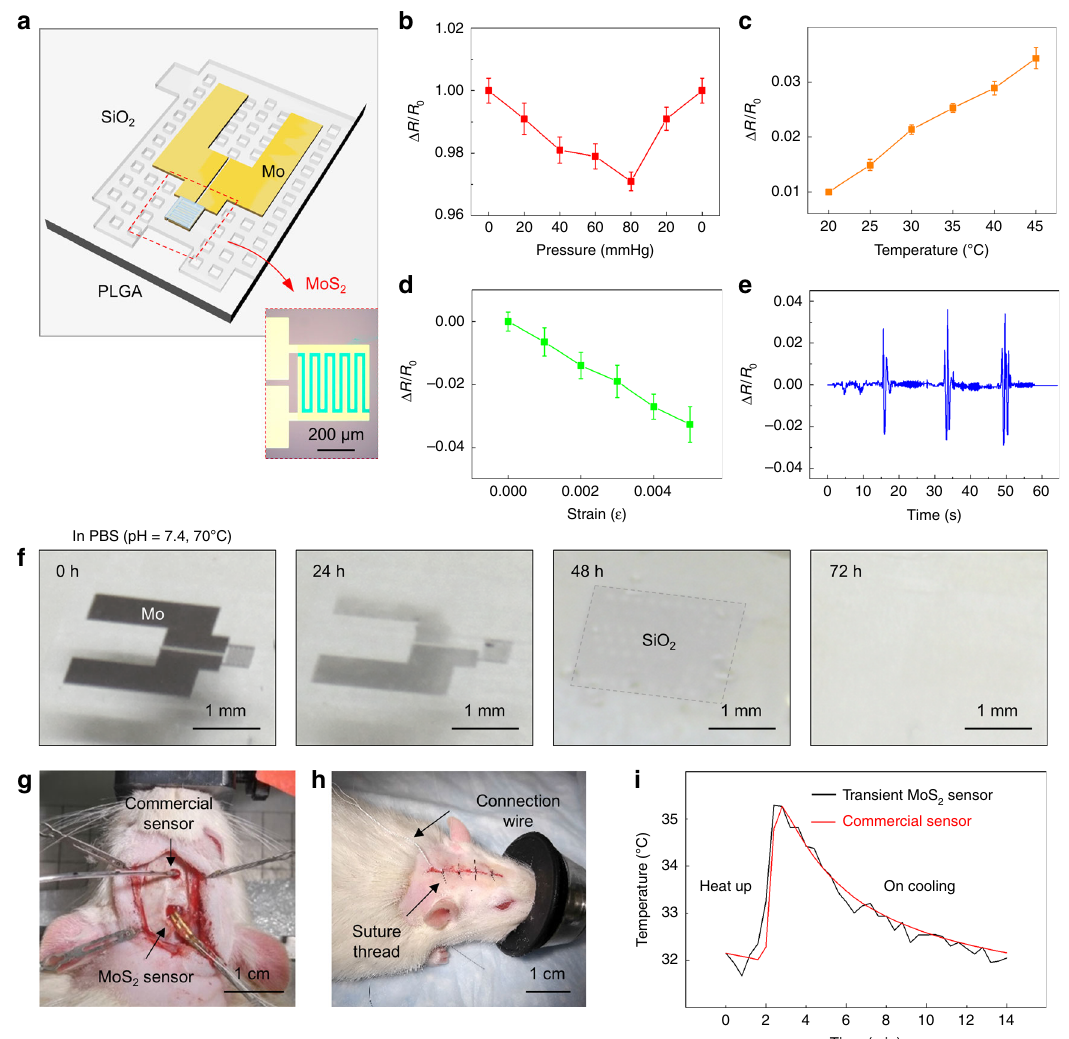
Fig. 5 Various applications of MoS 2 -based bioabsorbable sensors. a Schematic of the structure of a MoS 2 -based biodegradable sensor. Inset is the OM images of the sensor. b – e Characteristic responses of the sensor as a function of pressure ( b ), temperature ( c ), strain ( d ), and acceleration ( e ). Error bars of the experimental data represent standard error of mean. f Optical images of the sensor in PBS solution (pH 7.4) with different dissolution times (from 0 to 72 h). g , h Optical images of a MoS 2 -based bioabsorbable sensor implanted in a rat together with a commercial one before ( g ) and after ( h ) suture. i In vivo investigation of temperature changes in the intracranial space of the rat model using the implanted sensor, with comparisons to a commercial,